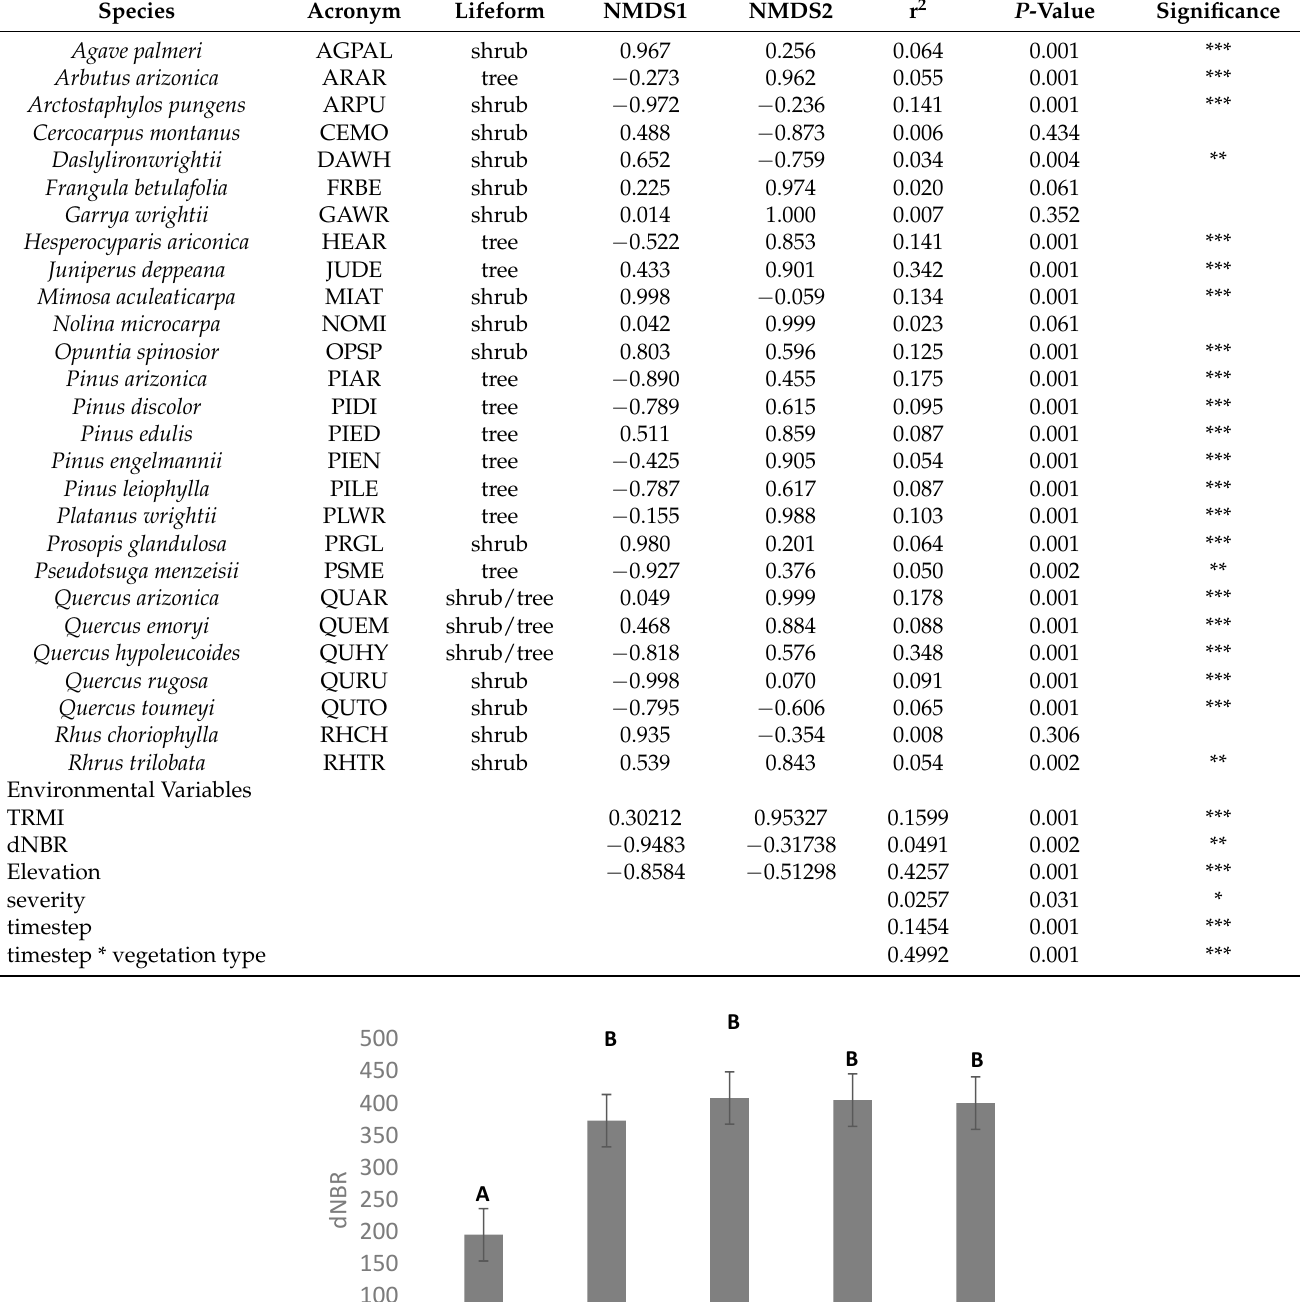
Table 2. Pearson correlations of species abundance and environmental variables with plot scores for nMDS axes for vegetation transects and environmental variables. Significant species correlations are indicated with asterisks (* = p > 0.05, ** = p > 0.01, *** = p > 0.001).